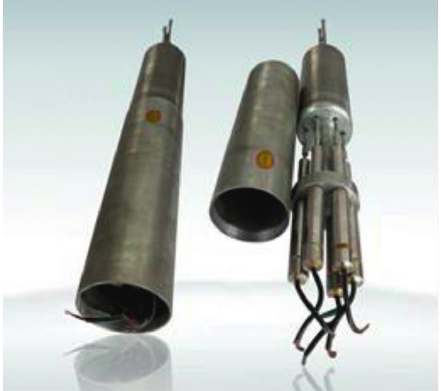
Figure 6: Multipoint (4-point) displacement meter (Shandong Heng’an Electronic Technology Co., Ltd.,